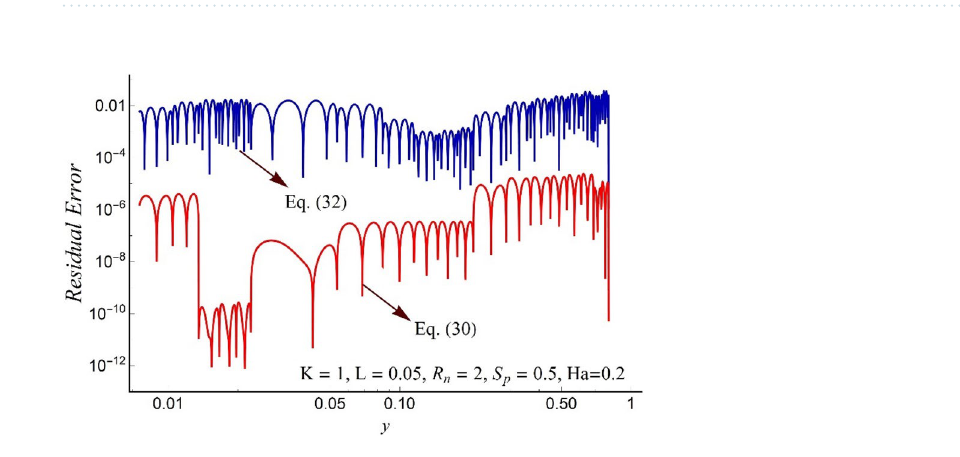
Figure 3. The residual error for the dimensionless governing Eqs. (31) and